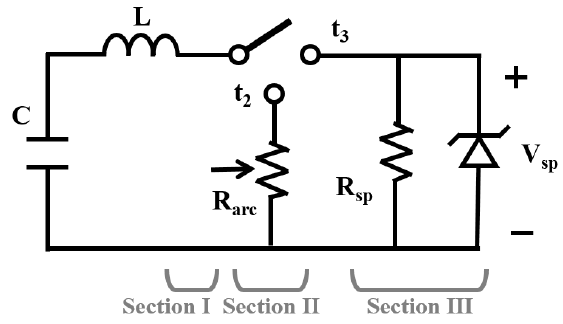
Figure 12. Circuit model for the MCCB interruption phenomenon.